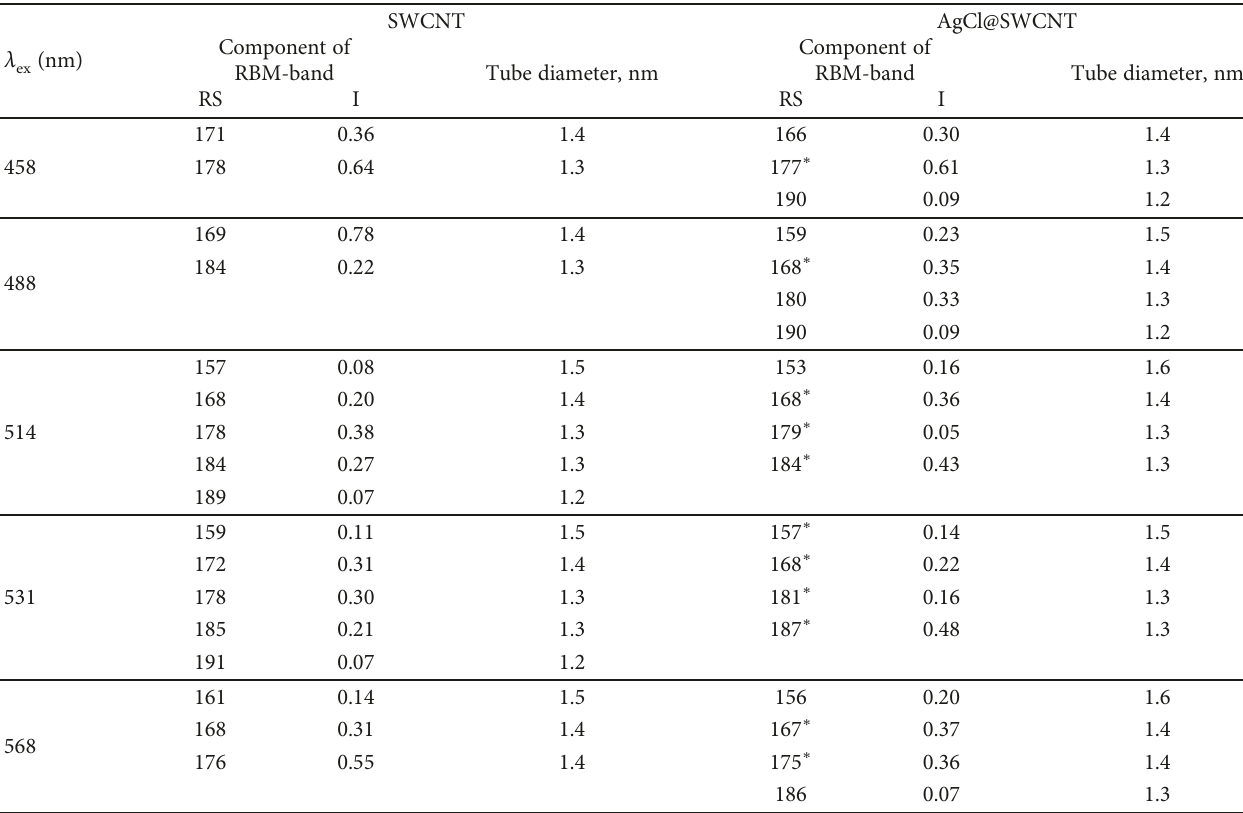
Table 1: The peak positions (RS) and relative area intensity (I) of the individual components of the RBM-band of Raman spectra of the pristine and AgCl- fi lled SWCNTs as well as diameters of the corresponding nanotubes. Asterisks denote the peaks in the spectra of the fi lled SWCNTs that are the same as in the spectra of the pristine